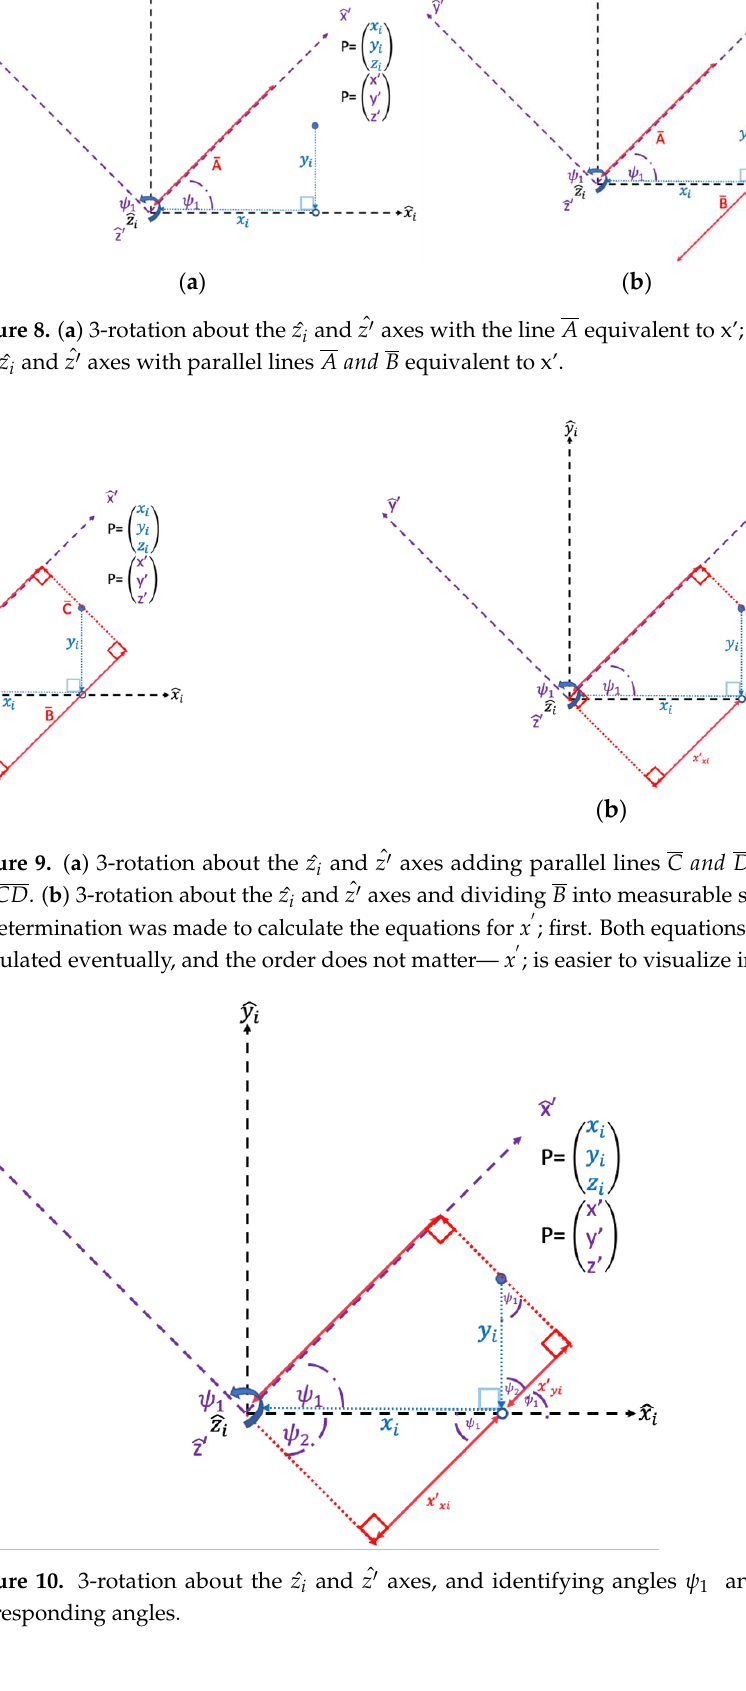
Figure 10. 3-rotation about the 𝑧 𝑖 ̂ and 𝑧′̂ axes, and identifying angles 𝜓 1 and 𝜓 2 and pertinent corresponding angles. Now two triangles can be identified, as seen in Figure 11, with two defined angles identified as 𝜓 2 and 𝜓 1 each with a defined side 𝑥 𝑖 or y 𝑖 . It can be seen that point P ’ s location on the 𝑥′ axis is positive, and because 𝑥 𝑖 and y 𝑖 are positive, 𝑦′ is a summation of each segment 𝑥′ 𝑥𝑖 and 𝑥′ 𝑦𝑖 . Therefore, both 𝑥′ 𝑥𝑖 and